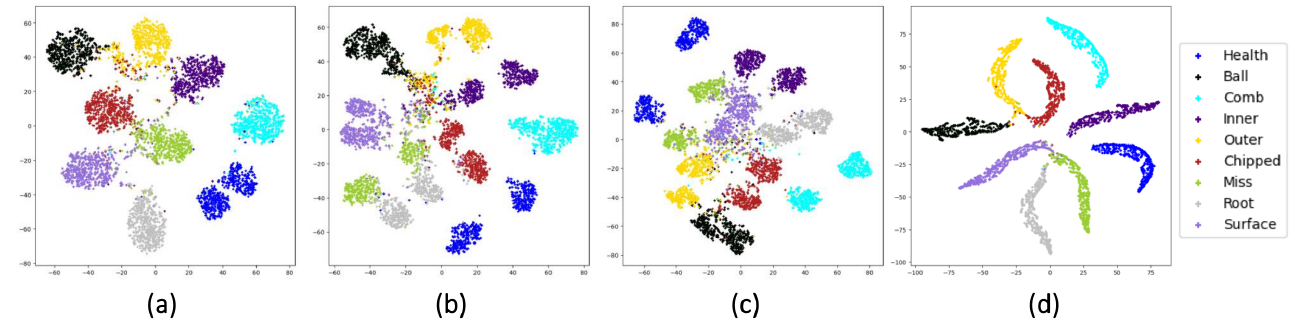
Figure 12. Feature maps visualization for SEU with noise and trend items: ( a ) visualization of FD- stream before the first fusion, ( b ) visualization of TFD-stream before the first fusion, ( c ) visualization of TD-stream before the first fusion, and ( d ) visualization after the second